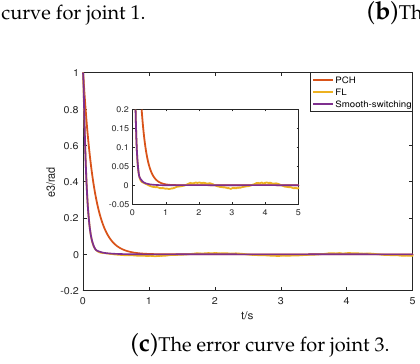
( c ) The error curve for joint 3. Figure 5. Error curves of three joints with q d = 1 + 0.5sin ( π t ) and σ =